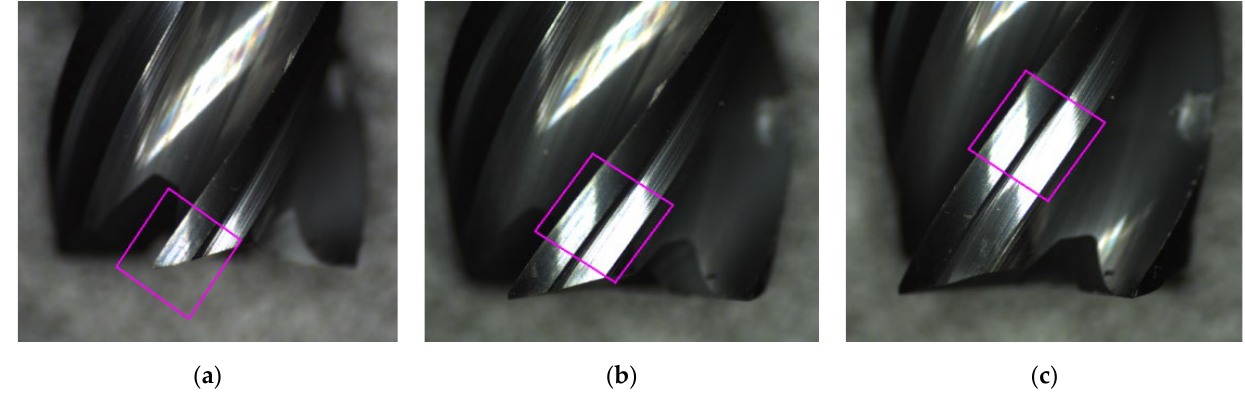
Figure 4. Collection images of the end mill side edge. ( a ) First layer; ( b ) Second layer; ( c ) Third layer.